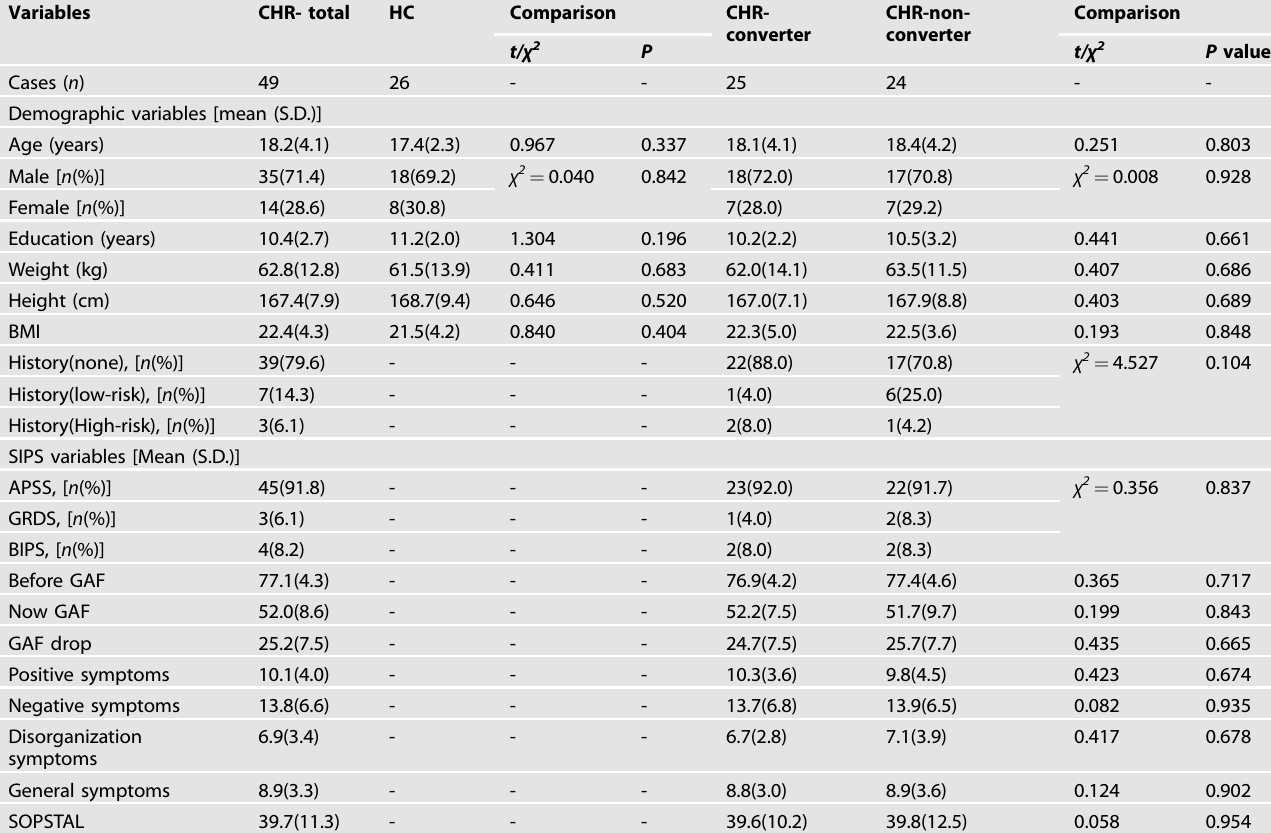
BMI body mass index, GAF drop GAF (Global Assessment of Functioning) score baseline from highest in the past year, low-risk family history having any family members with mental disorders or a fi rst-degree relative with non-psychotic disorders; high-risk family history having at least one fi rst-degree relative with psychosis, APSS attenuated positive symptom syndrome, GRDS genetic risk and deterioration syndrome, BIPS brief intermittent psychotic syndrome, CHR Clinical high risk for psychosis, CHR-converter CHR individuals who were converted to full psychosis, HC Healthy control, t/ χ 2 t for independent t test, χ 2 for kappa